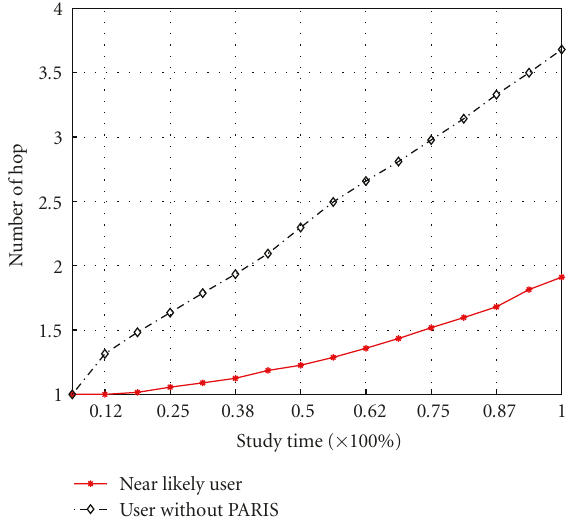
Figure 14: Comparison of hop counts during data retrieval with and without our proposed scheme in walking